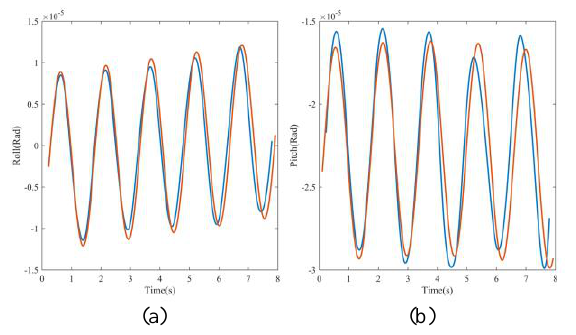
Figure 3 . Experiment image ((a)CCD1, (b)CCD2, (c)CCD3)